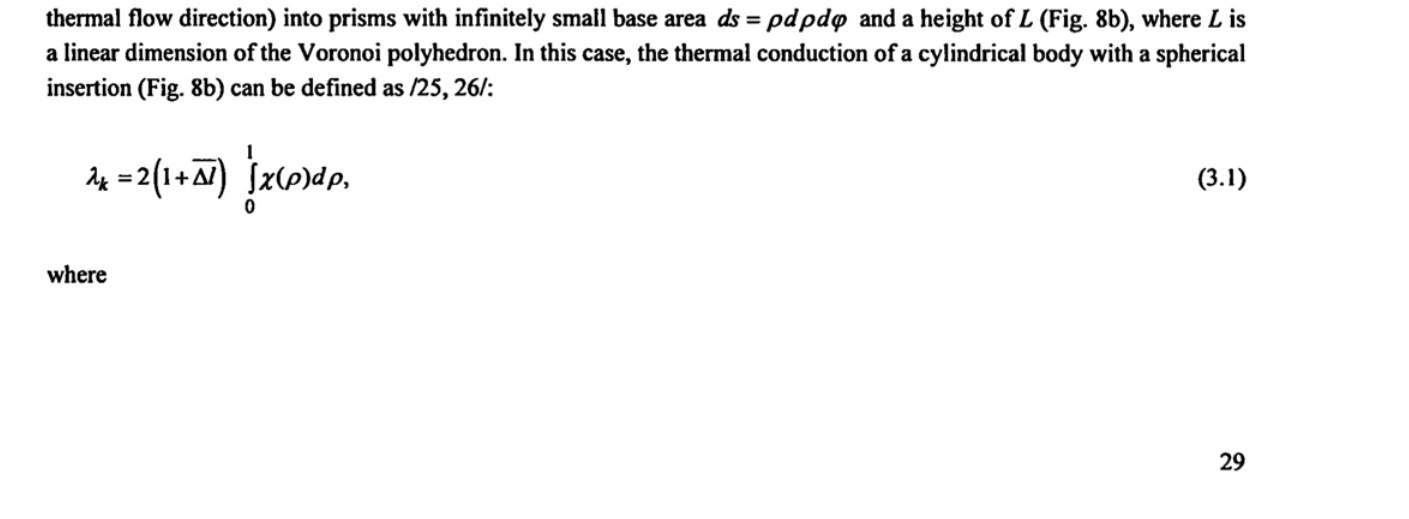
Fig. 8: Simplified representation of Voronoi polyhedron: a) sphere in a cube; b) sphere in a cylinder. The method of integral cuts is based on conditional division of a heterogeneous body in the given direction (in thermal flow direction) into prisms with infinitely small base area ds = pdpd<p and a height of L (Fig. 8b), where L is a linear dimension of the Voronoi polyhedron. In this case, the thermal conduction of a cylindrical body with a spherical insertion (Fig. 8b) can be defined as